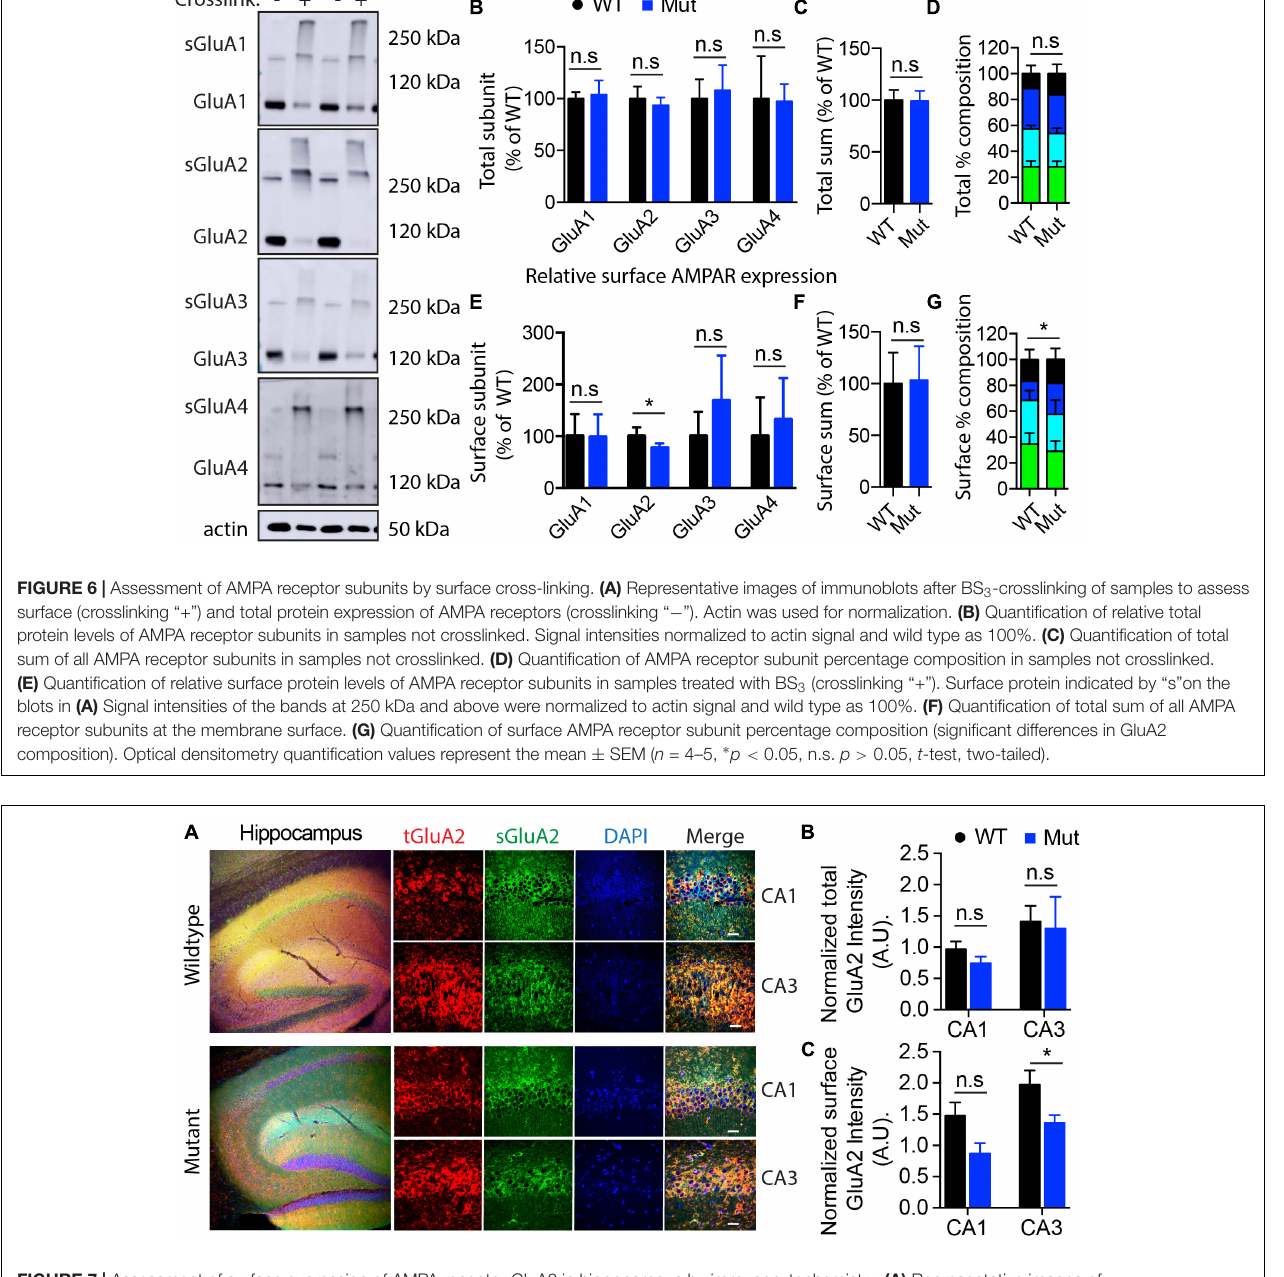
synaptic transmission we performed electrophysiological testing using coronal brain slices from A350V and WT IQSEC2 mice as described in methods. Evoked responses were recorded from the dendritic region of hippocampal CA1 pyramidal neurons.